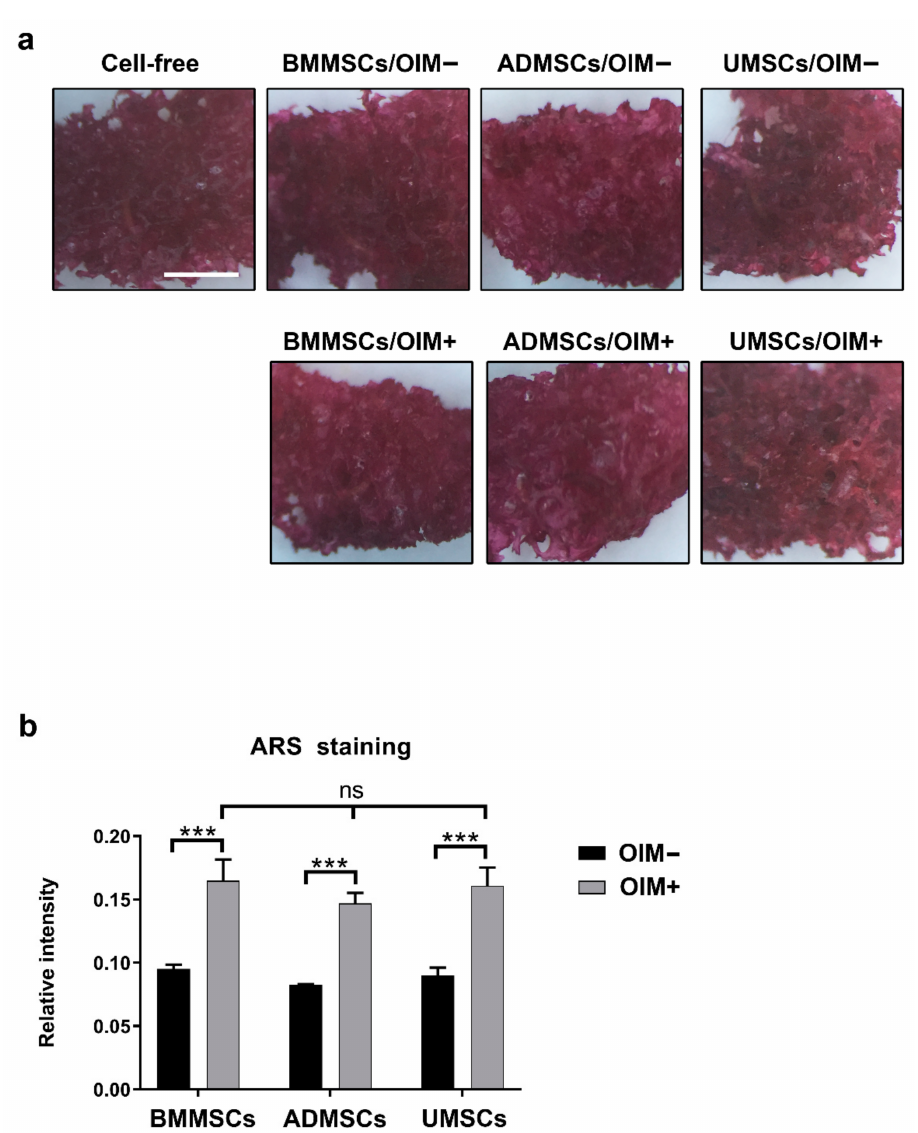
Figure 4. Identification of calcium deposition on hDCB blocks with hMSCs using Alizarin Red S staining. The hDCB blocks were seeded with hMSCs, and their osteogenic potential was analyzed after treatment with or without an osteogenic differentiation medium (OIM+ and OIM − , respectively) on day 14. ( a ) The production of bone ECM on cell-seeded hDCB blocks after osteoinduction was evaluated using Alizarin Red S staining. ( b ) The Alizarin Red S staining results were normalized to cell-free hDCB blocks. A one-way ANOVA with Turkey’s post hoc test was used to examine the differences between experimental groups. Statistical significance is represented as *** p < 0.001, and not significant (ns). Scale bars are 1